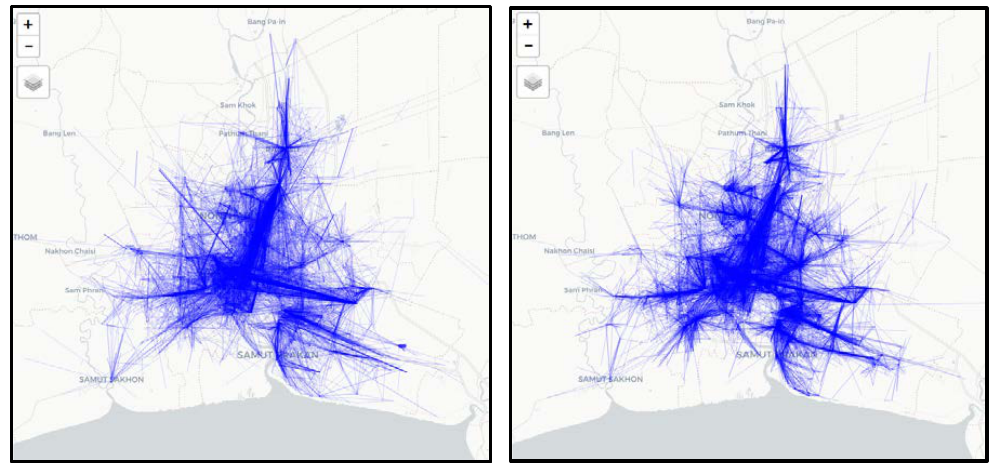
Figure 9. Passenger trip OD at time interval. Left : 7–8 a.m.; Right : 18–19 p.m.